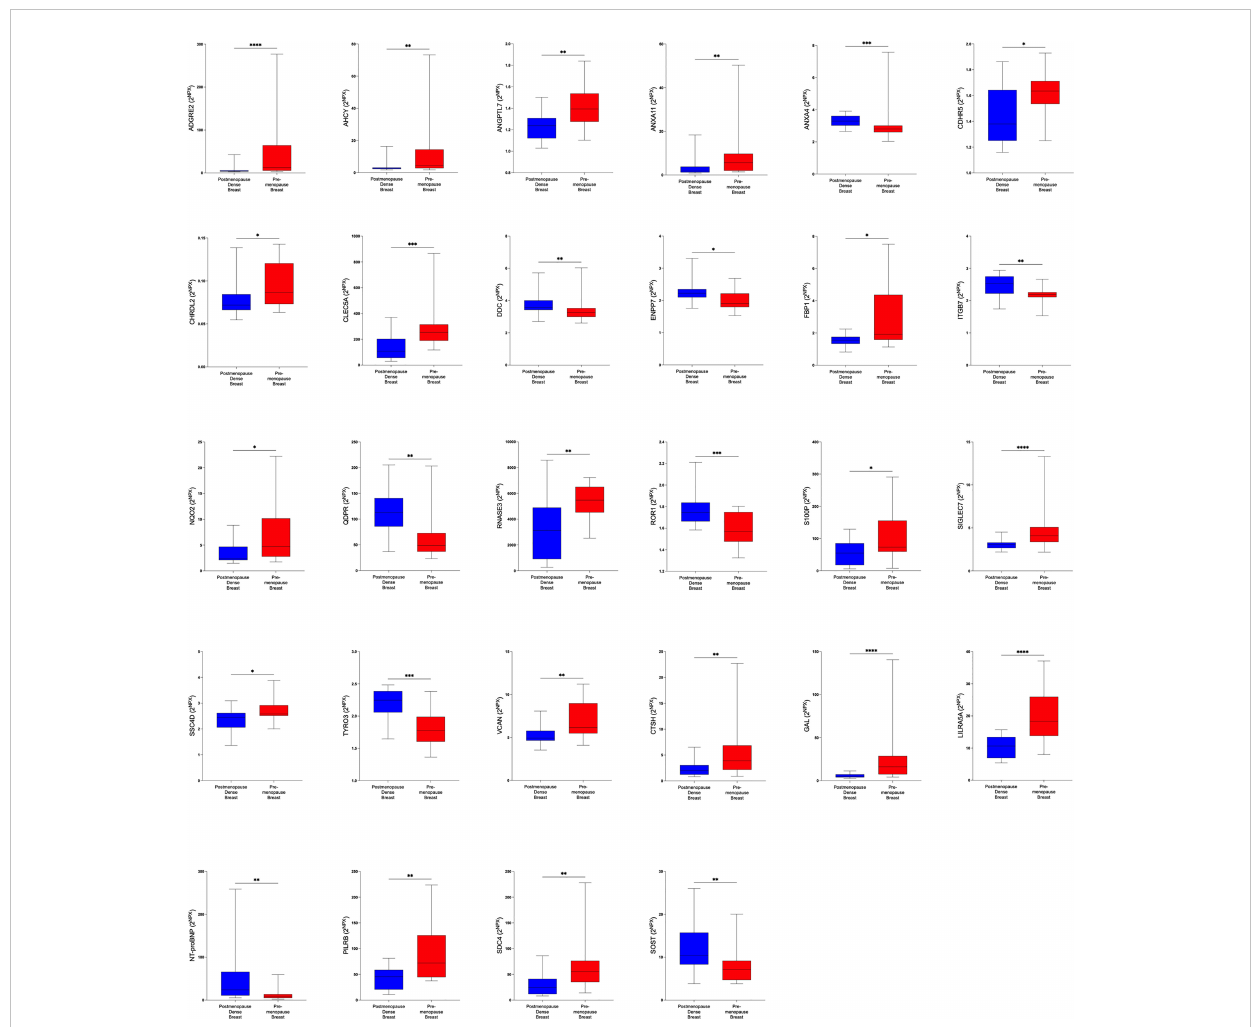
FIGURE 4 Signi fi cantly altered extracellular levels of proteins regulating metabolism in premenopausal breasts and postmenopausal dense breasts. 19 healthy premenopausal women in the luteal phase of the menstrual cycle and 20 healthy postmenopausal women with dense breast tissue were subjected to microdialysis in the upper lateral quadrant of the left breast. The levels of the signi fi cantly altered proteins that were depicted in Figure 1C are shown. Data are presented as box plots with whiskers of min and max values.* P <0.05, ** P <0.01, *** P